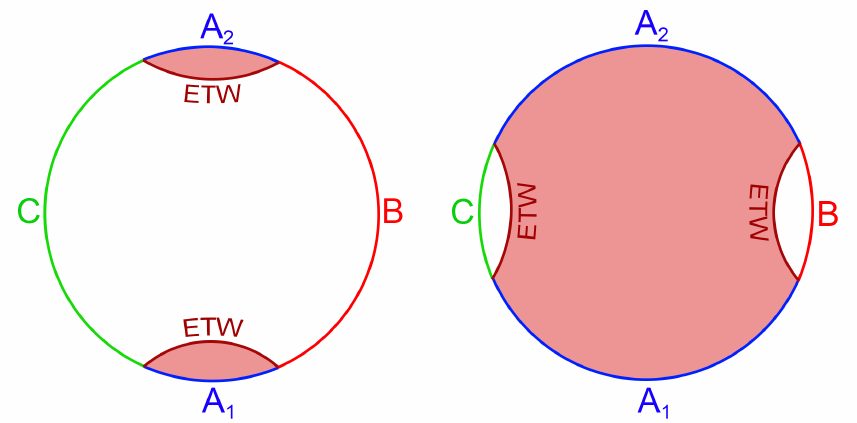
Figure 9 . Schematic representation of the λ 2 = 0 slice in the original coordinates describing the infinite cylinder with slits. The regions shaded in red are cut off by ETW branes and are not part of the geometry. Left: in the BTZ (connected) phase the slice is connected, and regions B and C share a large amount of entanglement. Right: in the thermal AdS (disconnected) phase the slice is 3 disconnected, and B and C are disentangled by the measurement performed on region A